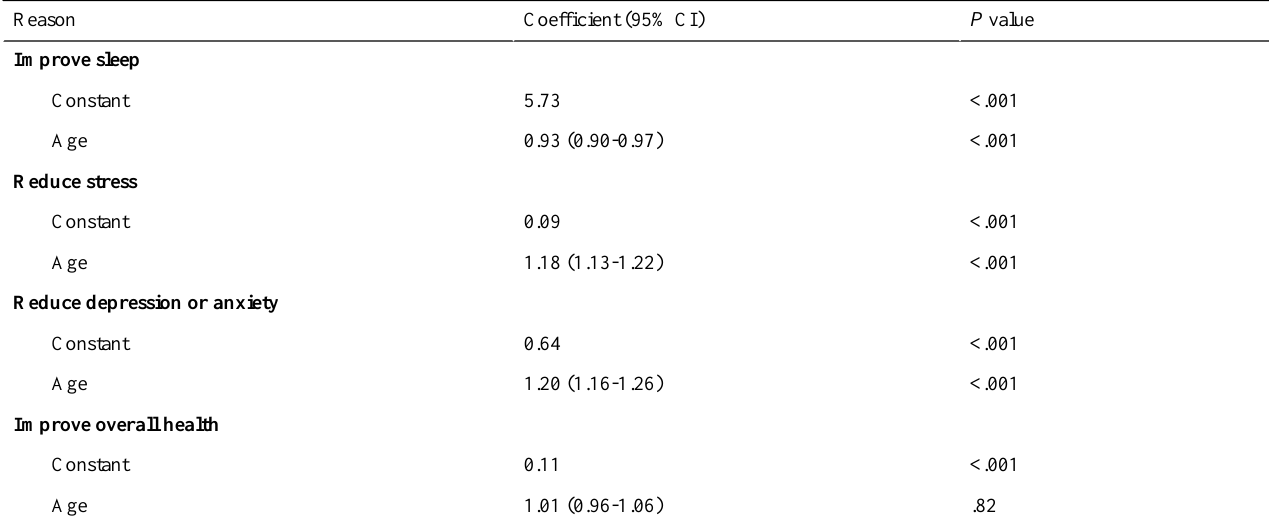
Table 2. Reasons for starting Calm by age (n=751).